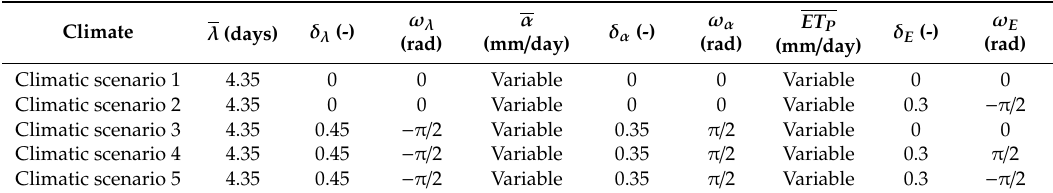
Table 1. Parameters of the sinusoidal Equations (2)–(4) that define the particular pattern of precipitation and potential evapotranspiration, related to the considered climatic scenario. δ λ , δ α and δ E represent the ratio of the semi-amplitude of the sinusoidal equations to their mean value, whereas ω λ , ω α , and ω E are the initial phase. λ , α , and ET P are respectively the average interarrival time, the average amount of daily precipitation, and the average daily potential evapotranspiration.